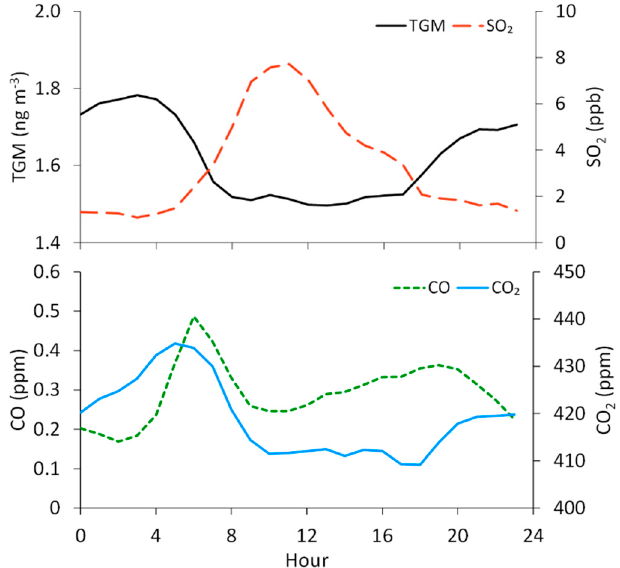
Figure 4. Overall hourly-averaged concentrations of TGM and mixing ratios of SO 2 , CO, and CO 2 at the measurement site. Hours are in Mountain Standard Time (MST), and the averages are assigned to the starting hour of each 1 h period. The means of each hourly standard deviation (not shown graphically) are 0.2 ng m − 3 , 6.1 ppb, 0.16 ppm, and 20 ppm for TGM, SO 2 , CO, and CO 2 , respectively.